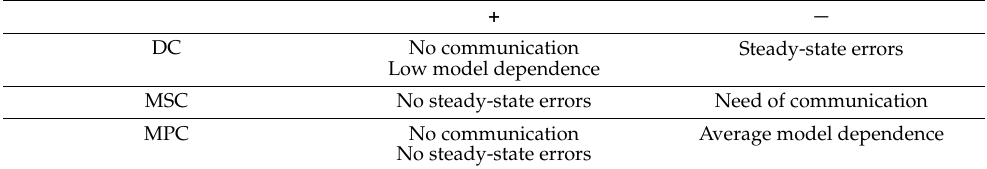
Table 13. Pros and cons of the control methods: DC: Droop Control, MSC: Master–Slave